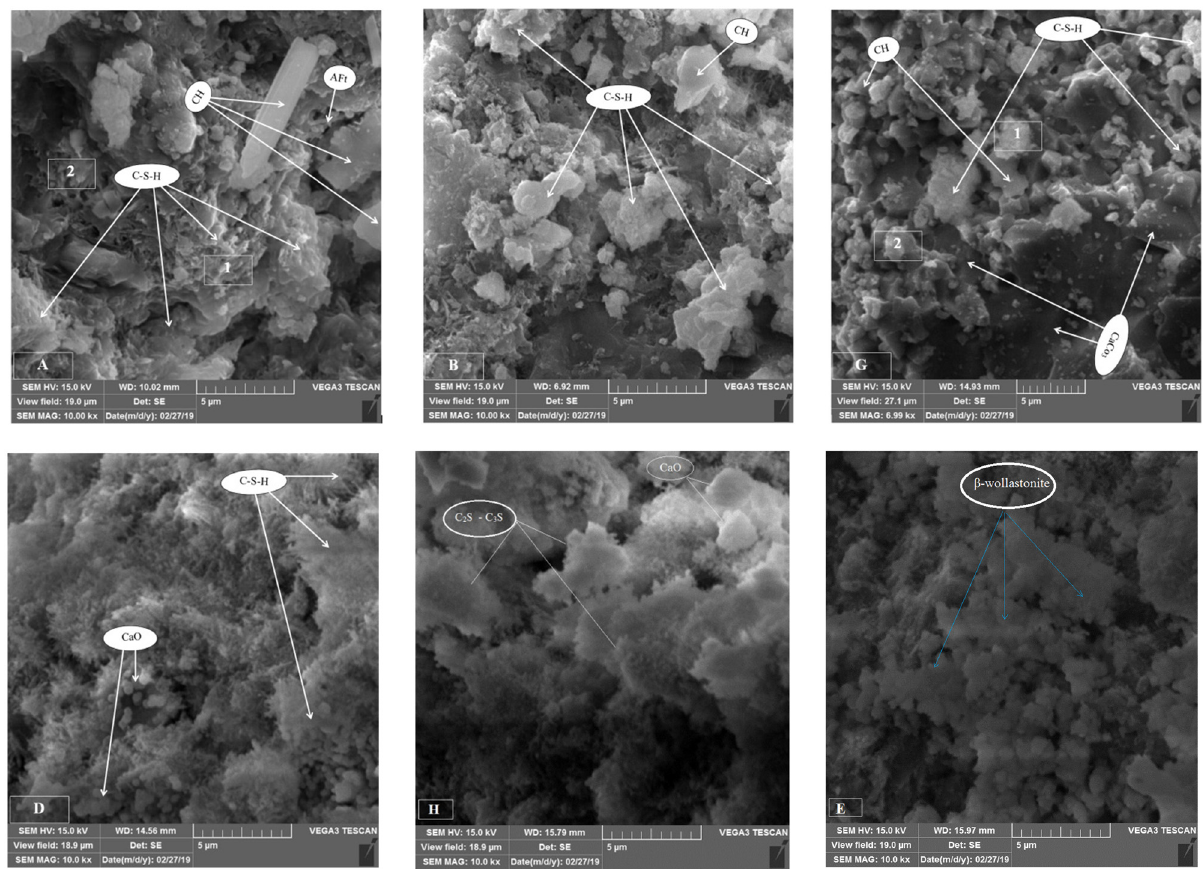
Figure 3: SEM images of the concrete samples at: ( a ) 25°C, ( b ) 100°C, ( c ) 300°C, ( d ) 500°C, ( e ) 700°C, and ( f ) 900°C. ( AFt: ettringite, C 3 S: alite, C 2 S: belite, C – S – H: calcium silicate hydrate, CH: Portlandite, Q: quartz, Ca: calcite, CaO: Calcium oxide, β - W: β - wollastonite, T: tridymite )